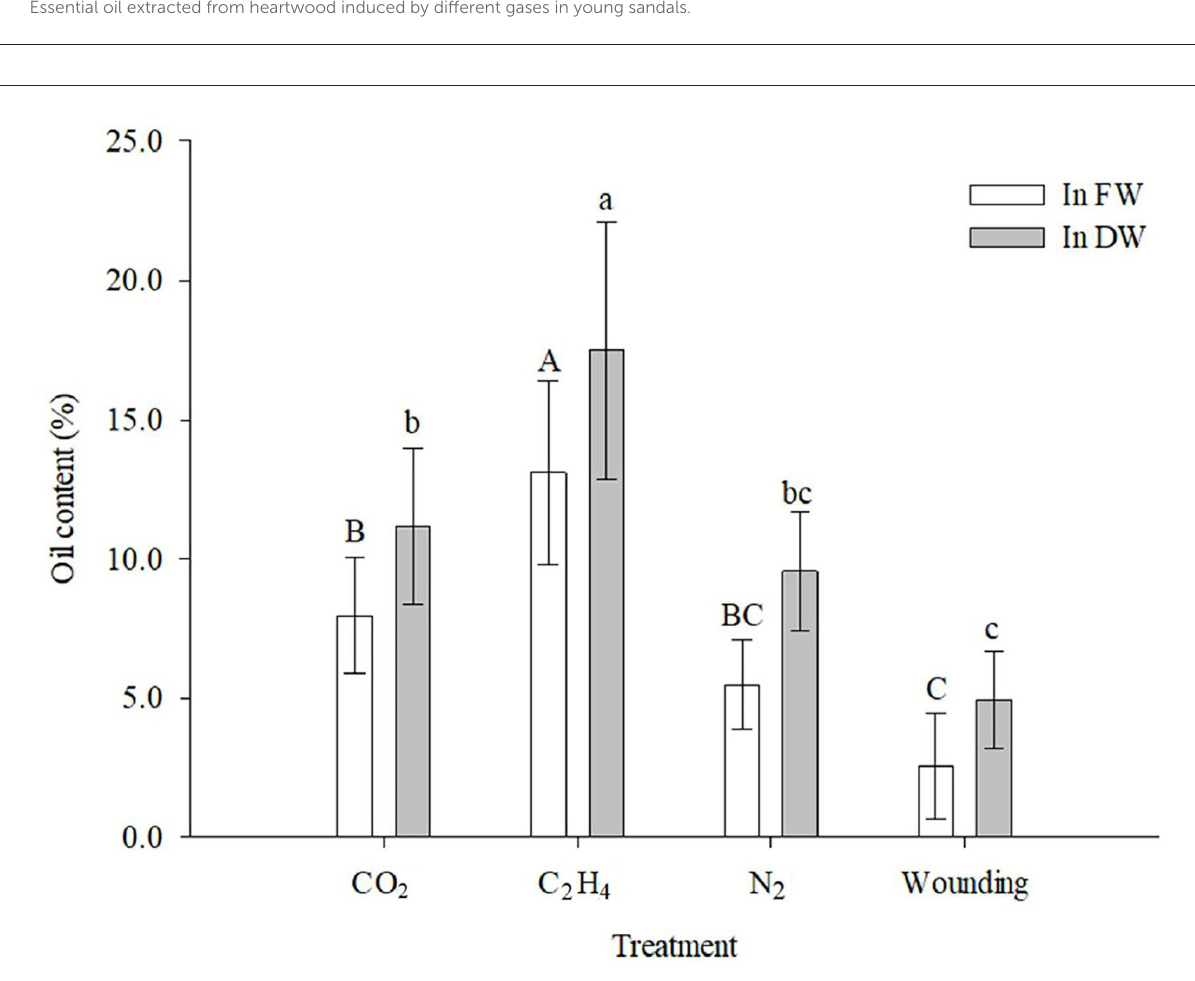
FIGURE4 Essential oil extracted from heartwood induced by different gases in young